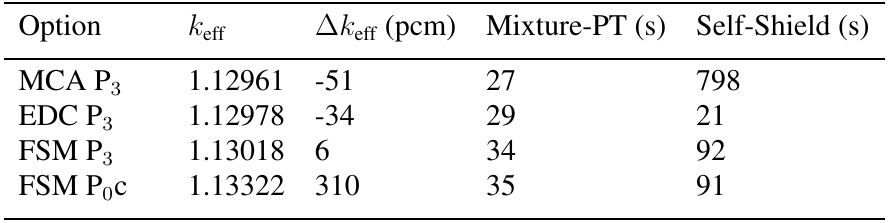
discrepancies and CPU times eff